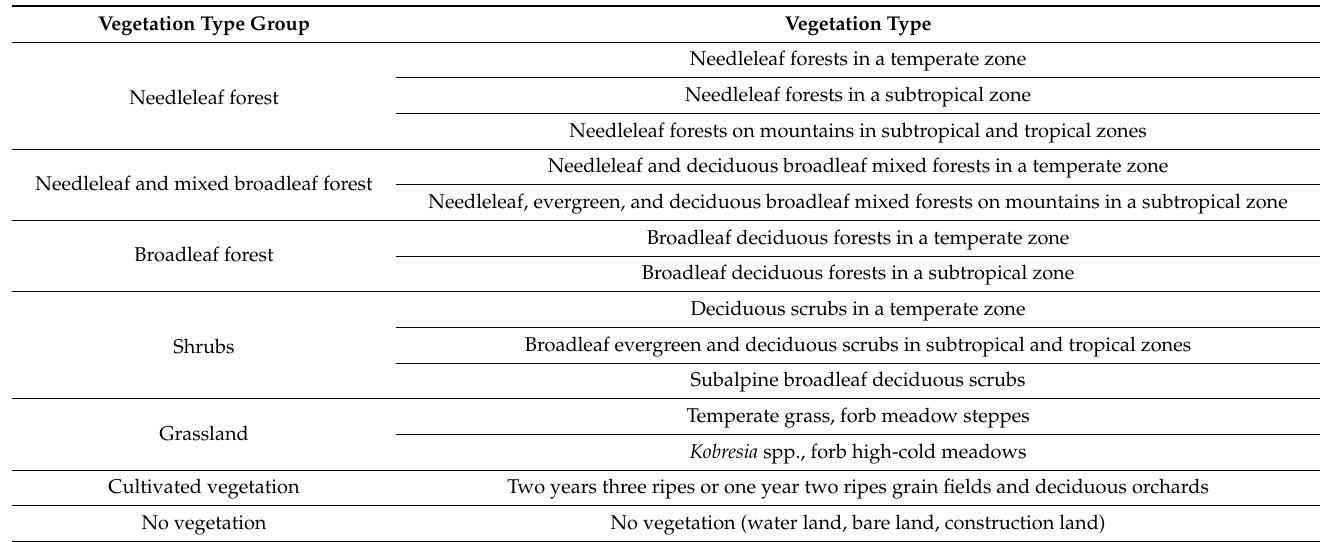
Table 1. Vegetation classification system of Taibai